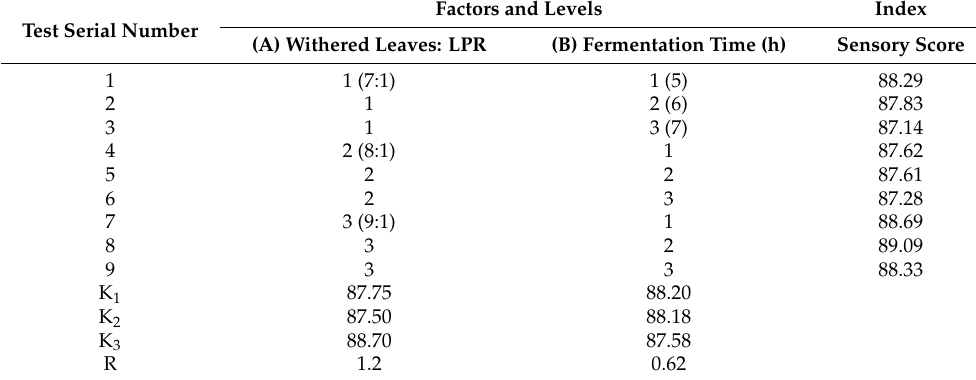
Table 3. Orthogonal test results.